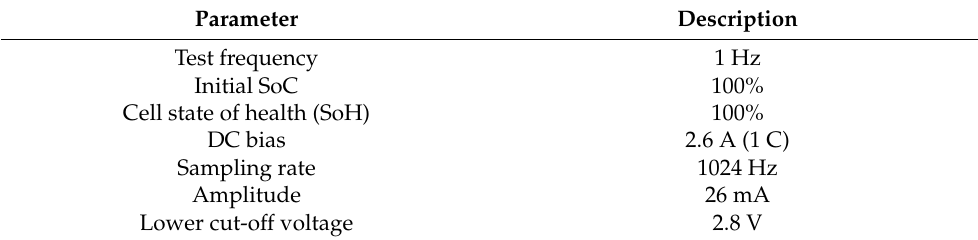
Figure 2. Simulation result of cell voltage, 1 Hz impedance, and THD while one LIB cell is discharged. Table 1. Conditions for THD simulation of a LIB cell being discharged.